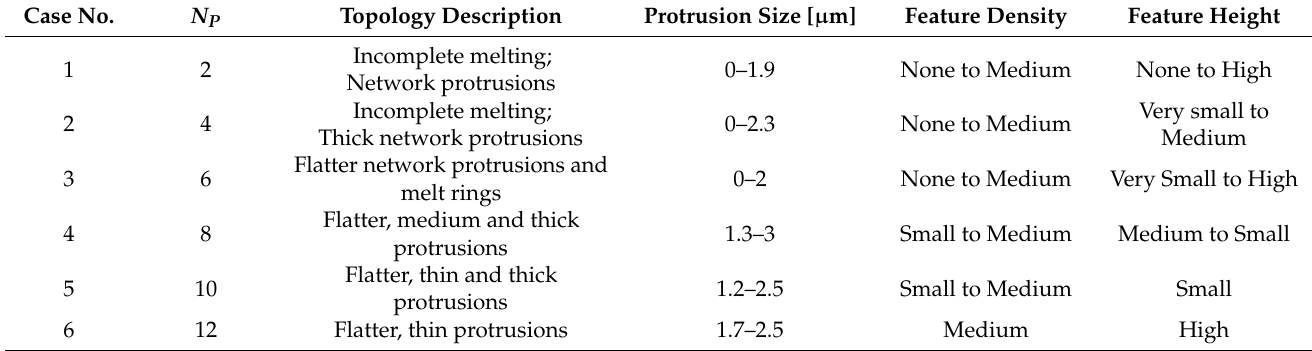
Figure A2. SEM micrographs for one-beam laser processed Cu specimens using the spot-by-spot method with a 5 mm spot size for number of pulses per spot of: ( a ) 8, ( b ) 10, and ( c ) 12. Table A3. Topology variation for one-beam laser processed Cu specimens with 5 mm spot size.